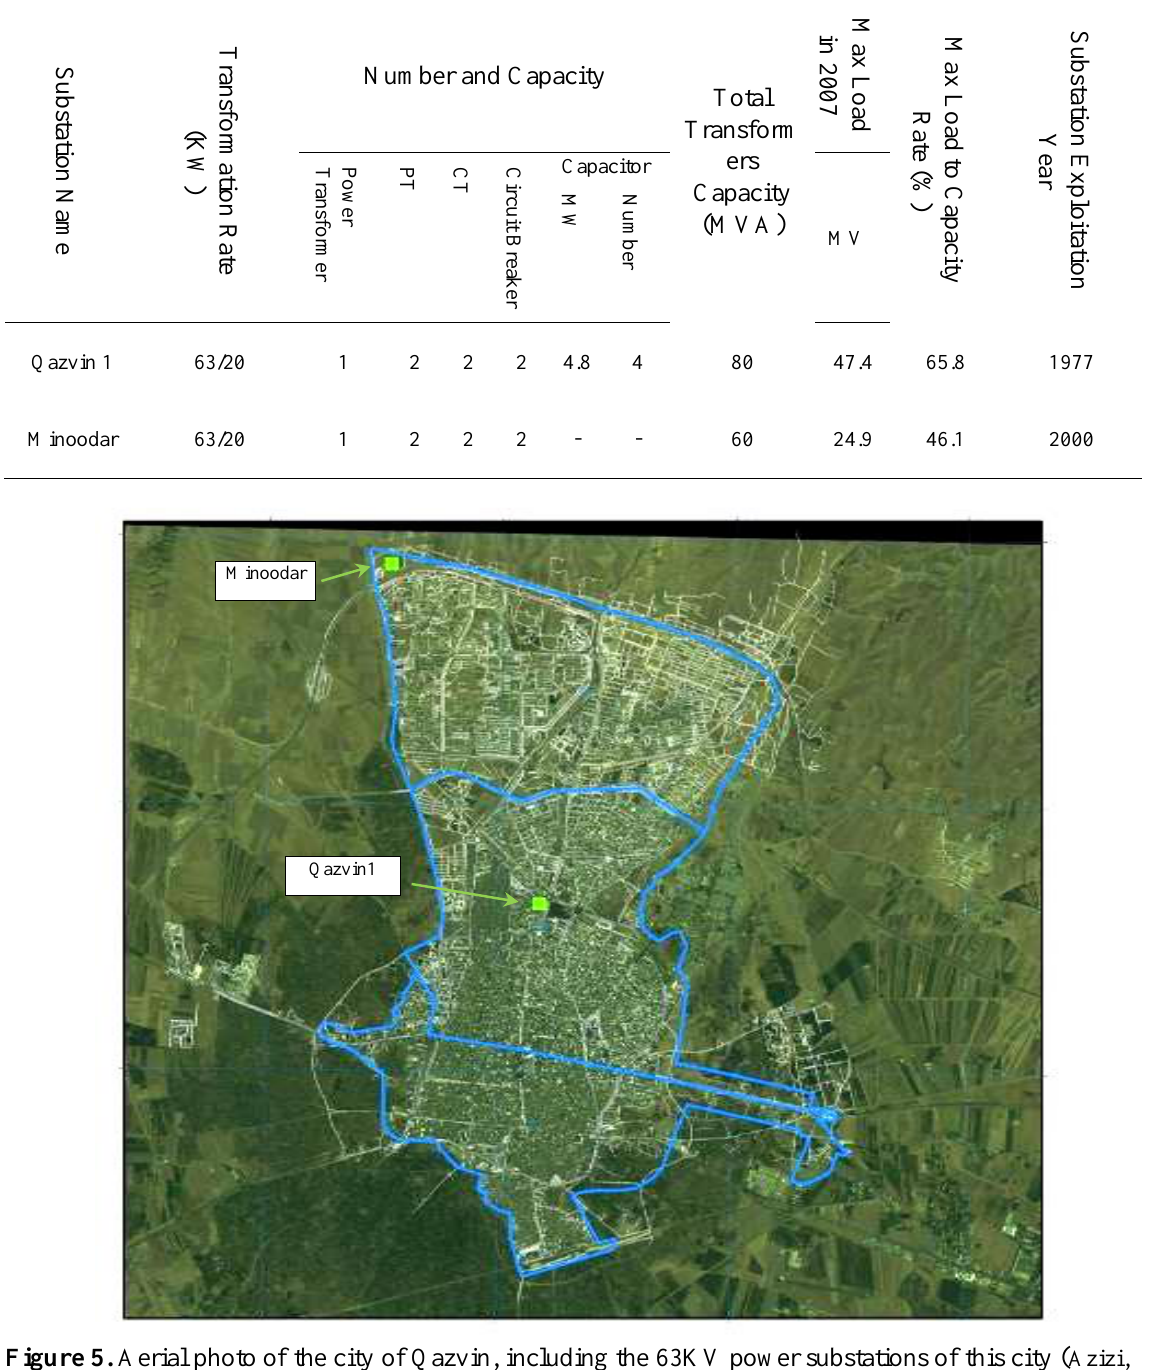
Table 3. The specifications of 63 KV substations of Qazvin (Azizi, 2009)